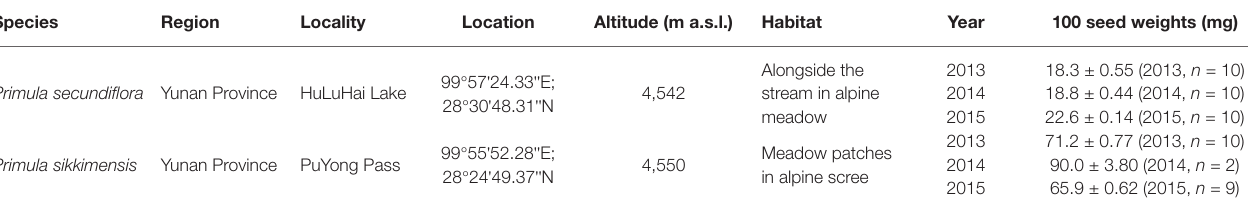
TABLE 1 | Collection sites of seeds for two Primula species. Species Region Locality Location Altitude (m